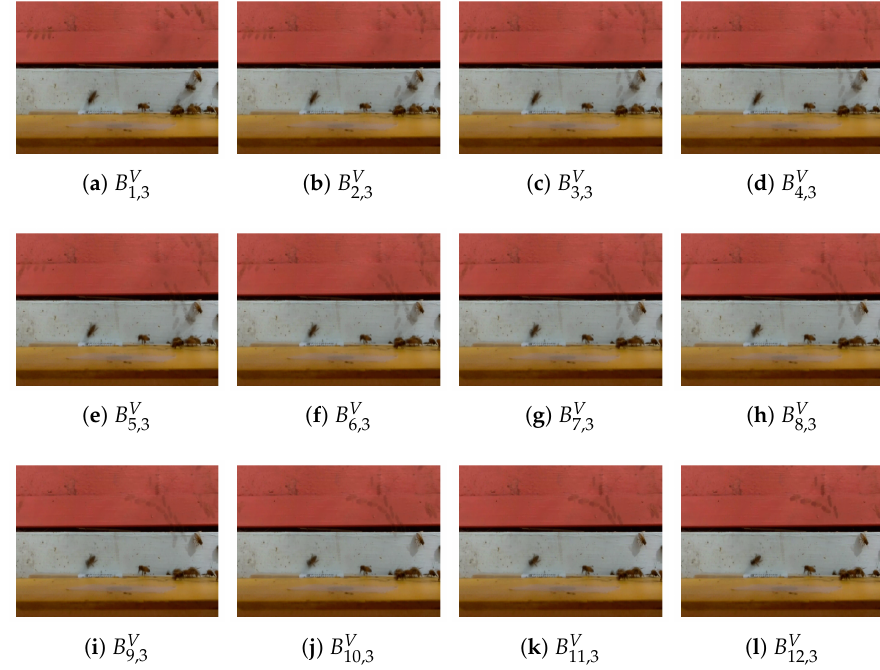
Figure 3. Twelve dynamic background frames of video V in Figure 2 with ∆ =